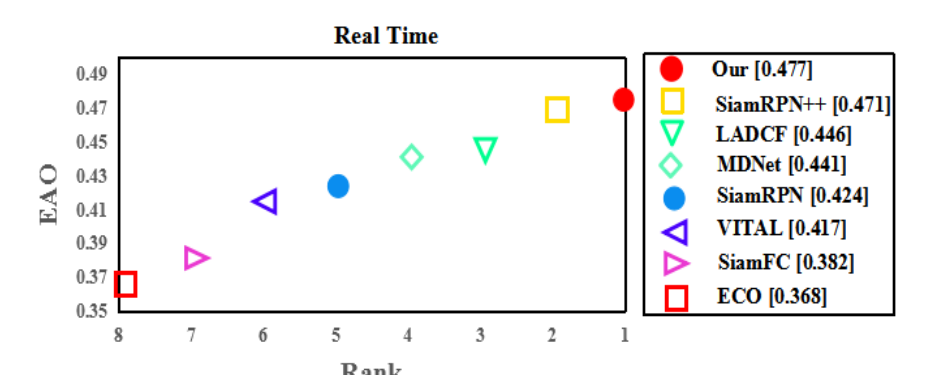
Figure 3. State-of-the-art evaluation on VOT-2020.